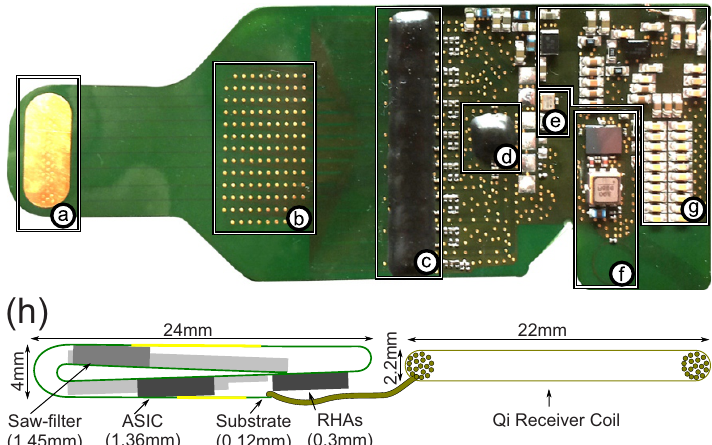
Figure 3. (top) implant prototype: ( a ) reference electrode; ( b ) 128 electrodes; ( c ) 8x Intan Technologies RHA2116; ( d ) ASIC (Application-specific integrated circuit); ( e ) 24 MHz clock; ( f ) radio frequency (RF)-transceiver; ( g ) inductive energy link. Implant has a weight of 1.72 g and is 32 mm wide; ( h ) drawing of the folded implant. The coil has a square